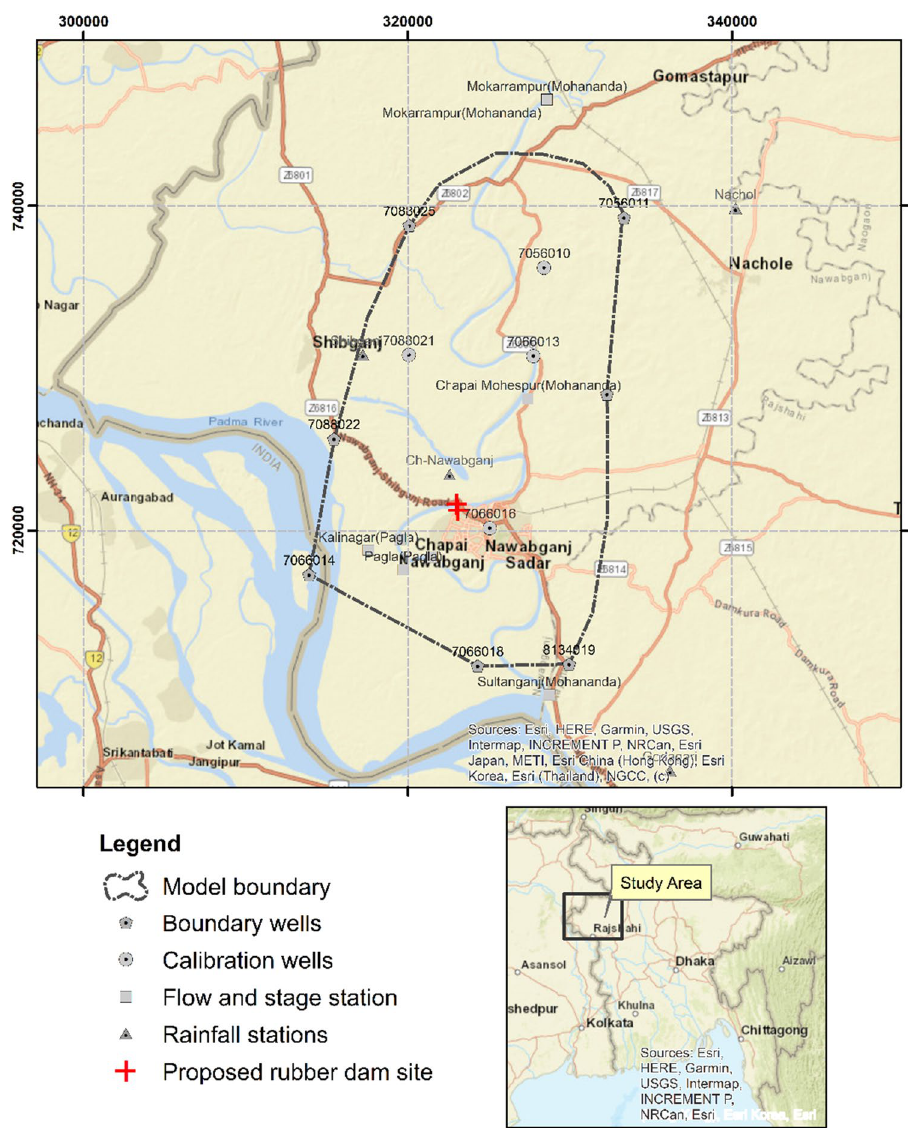
Fig. 1 Study area map showing the model boundary, bound- ary and calibration wells for groundwater model, discharge and water level measuring stations for the river model and the rainfall stations. The Mohananda river is flowing through the central region of the model domain from north to south. The Ganges river is located to the south of the study area and flowing from west to east. The Mohananda and the Ganges rivers meet at Godagari Upazila, located to the south of the map. It also shows the loca- tion of the proposed rubber dam to be used for creating a storage reservoir during the dry